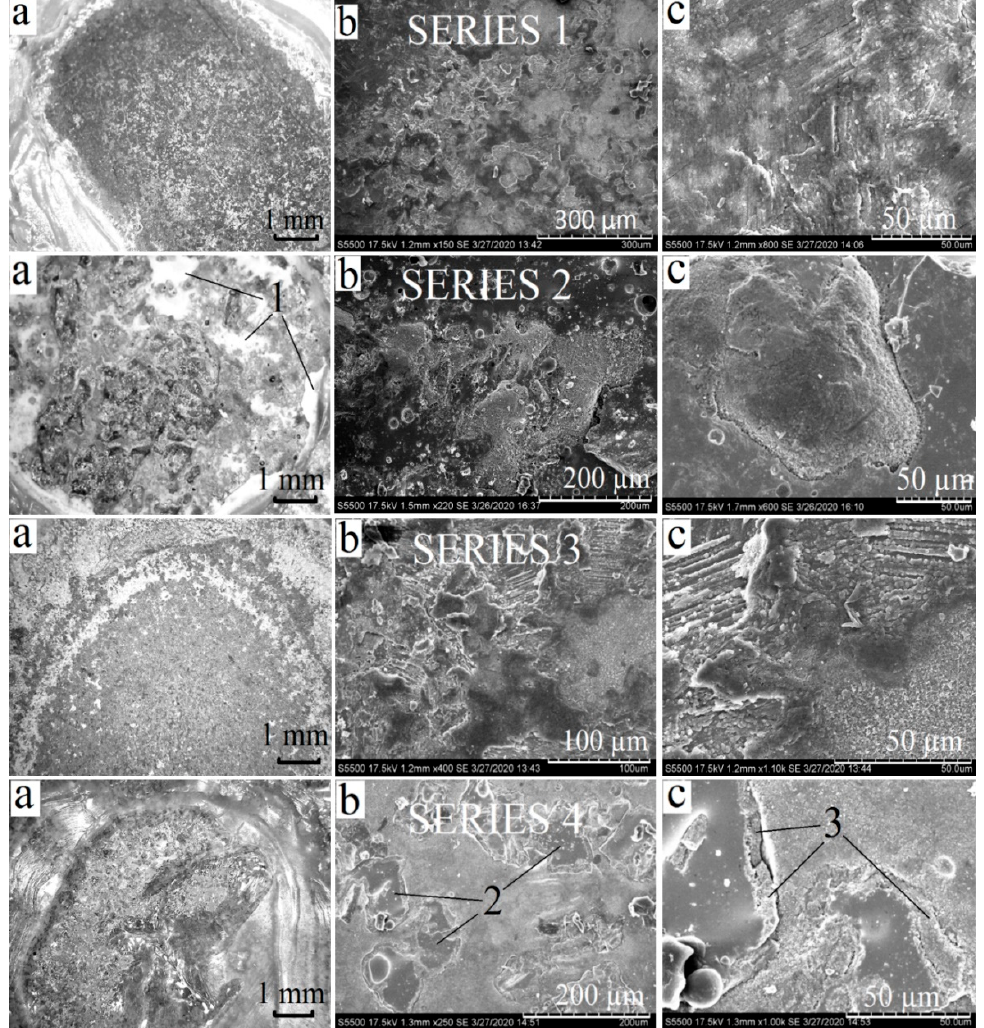
Figure 8. Surface of samples after testing: ( a ) optical microscopy; ( b , c ) SEM. Zones are marked as follows: 1—areas coated with remains of adhesive; 2—material of the coating remained in pores; 3—intermediate layer between titanium substrate and silicate coating.